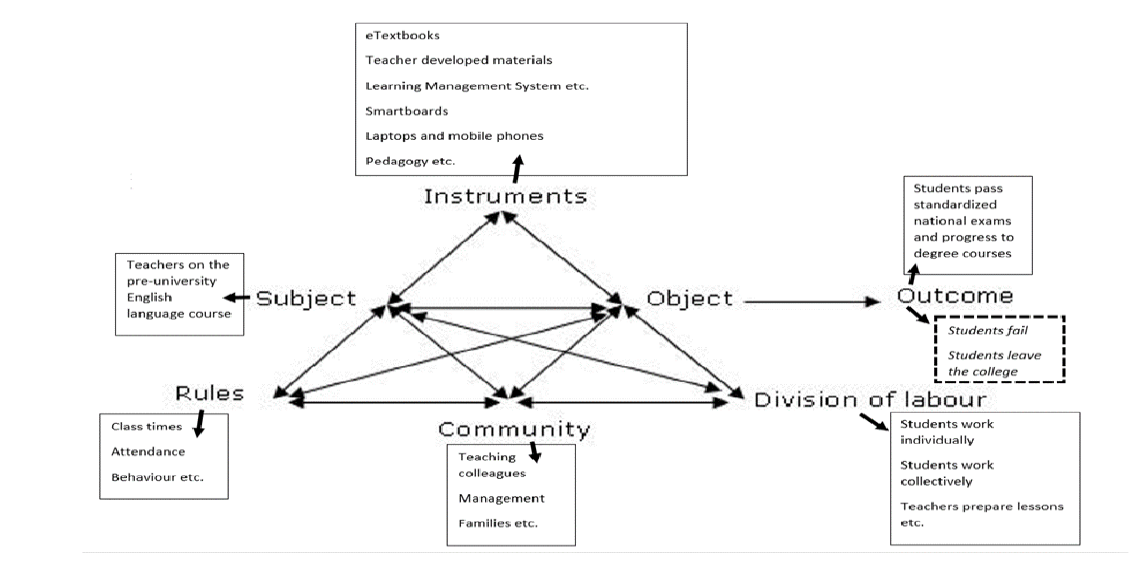
Figure 5: the current activity